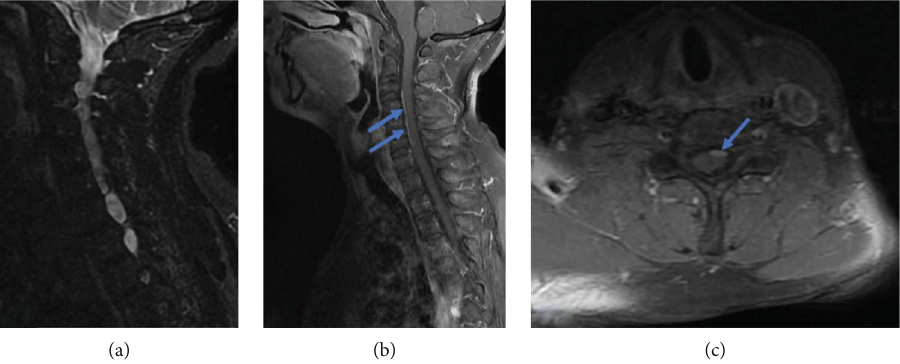
Figure 2: Cervical MRI, (a) STIR sagittal and (b, c) T1 sagittal and axial sequences after injection of Gadolinium; nodular contrast enhancement on the anterior surface of the left hemimarrow (blue arrows): appearance in favor of preganglionic